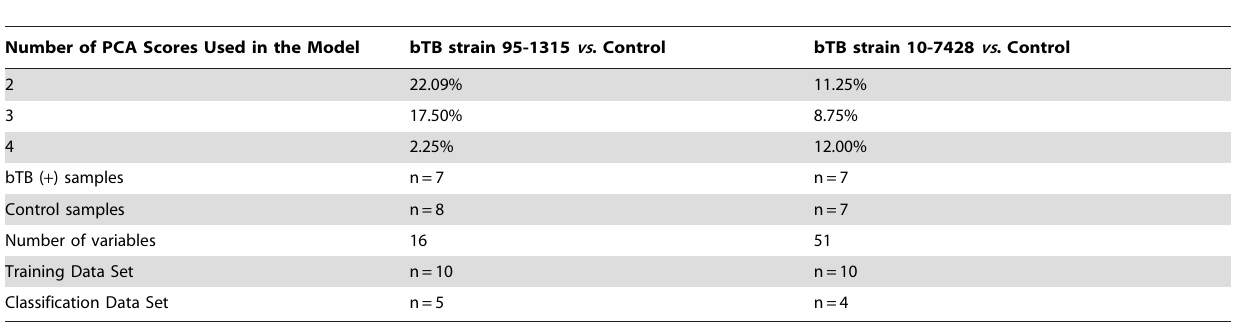
Table 3. Misclassification rates for Least Discriminant Analysis (LDA) models based on Principle Components Analysis (PCA) scores for XCMS Online